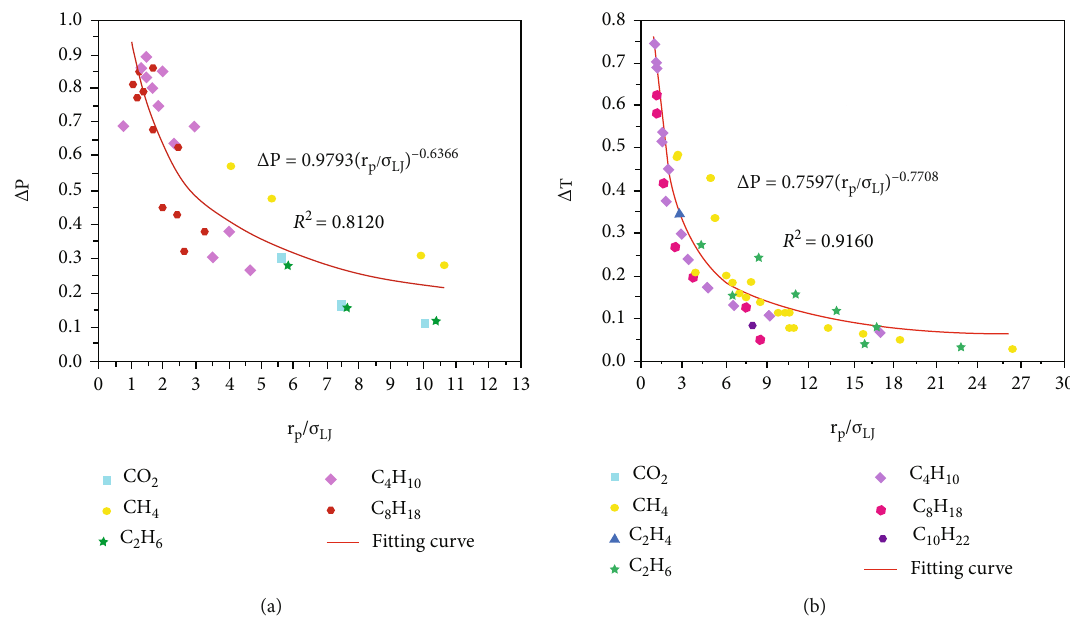
Figure 2: (a) Correlation of shift of critical pressure and (b) correlation of shift of critical temperature with the dimensionless pore